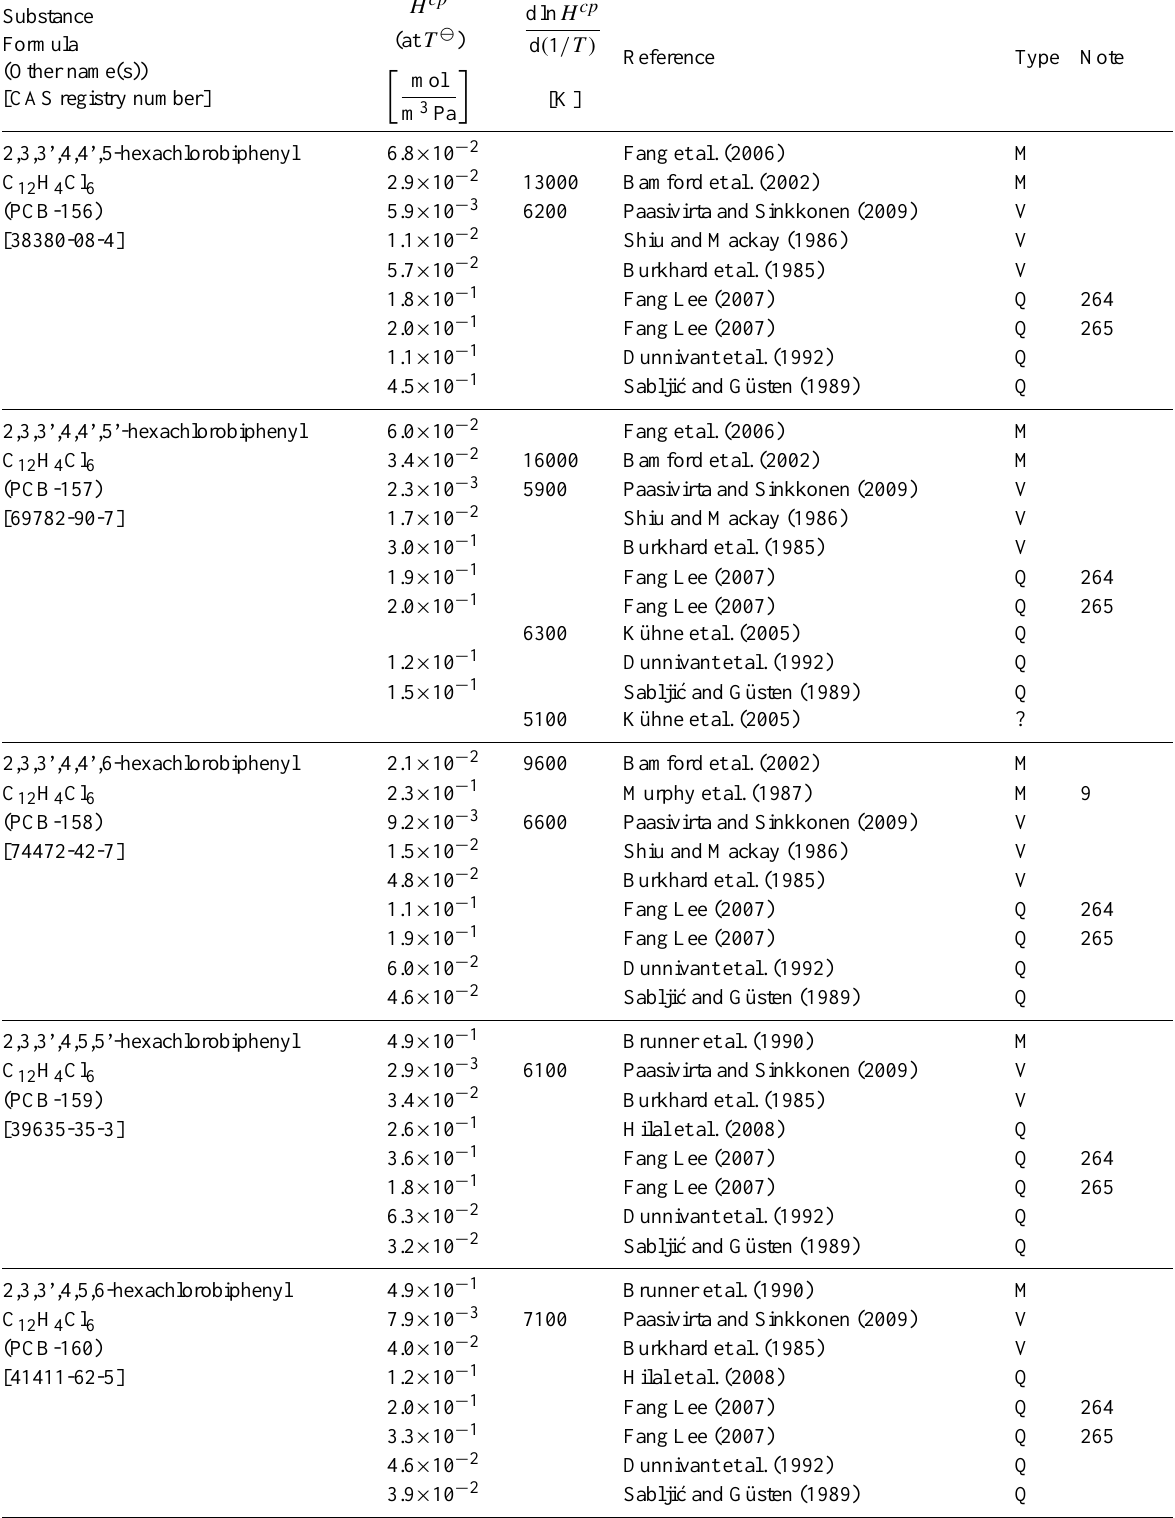
Table 6: Henry’s law constants for water as solvent